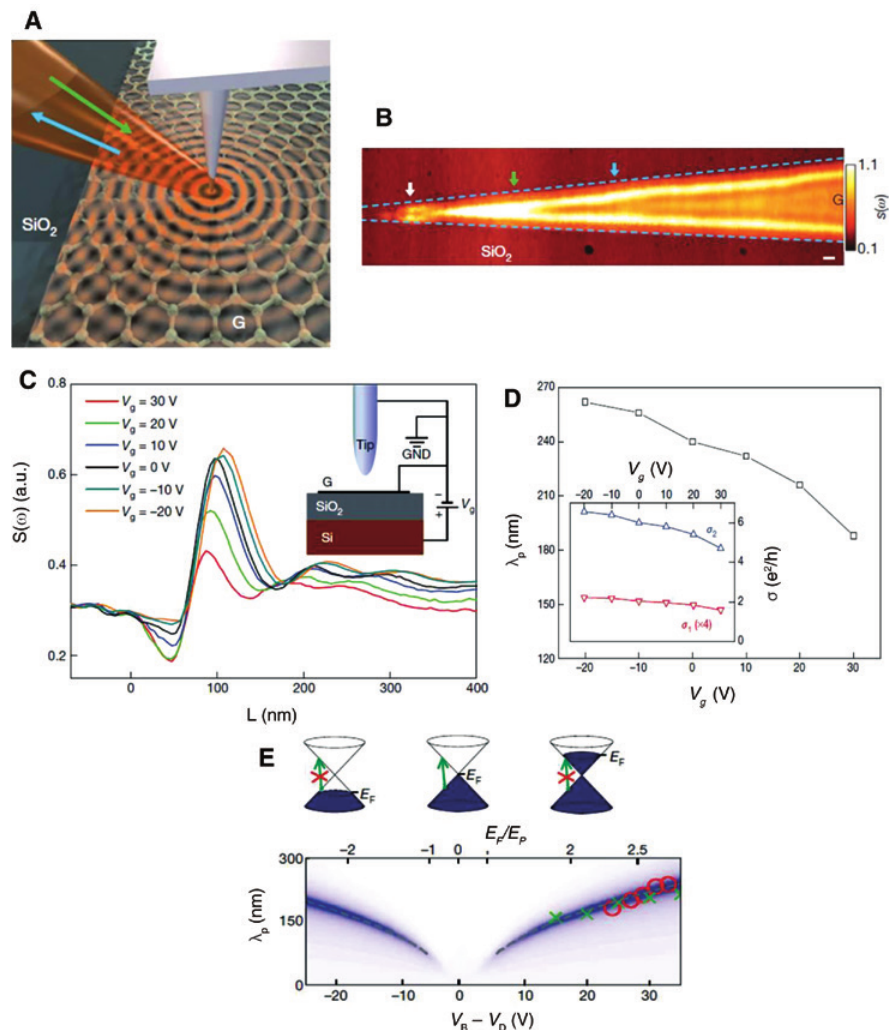
Figure 4: Propagating mid-IR plasmons in graphene. (A) Illustration of the s-SNOM experimental configuration. (B) Typical s-SNOM imaging of graphene plasmon near graphene edges.